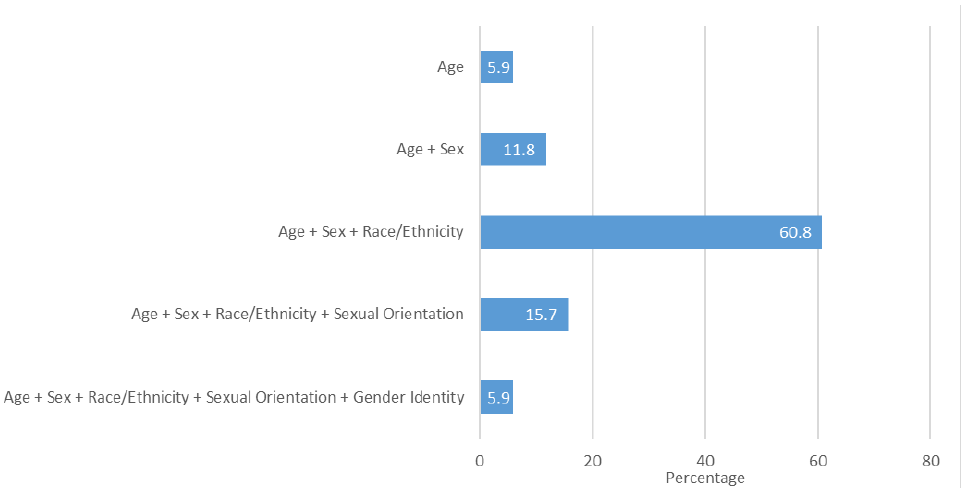
Figure 1. Percentage of U.S. public health data and monitoring systems collecting data on sex, sexual orientation, gender identity, age, and race/ethnicity, 2015–2018.